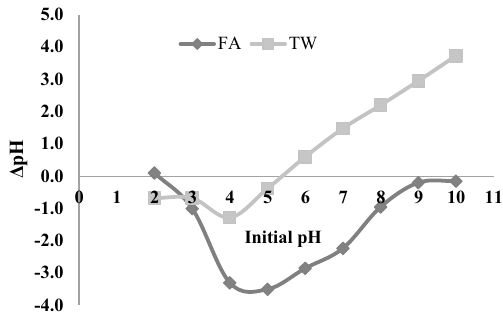
Fig. 6 Variation of ΔpH with the change in initial pH of adsorbent– solution